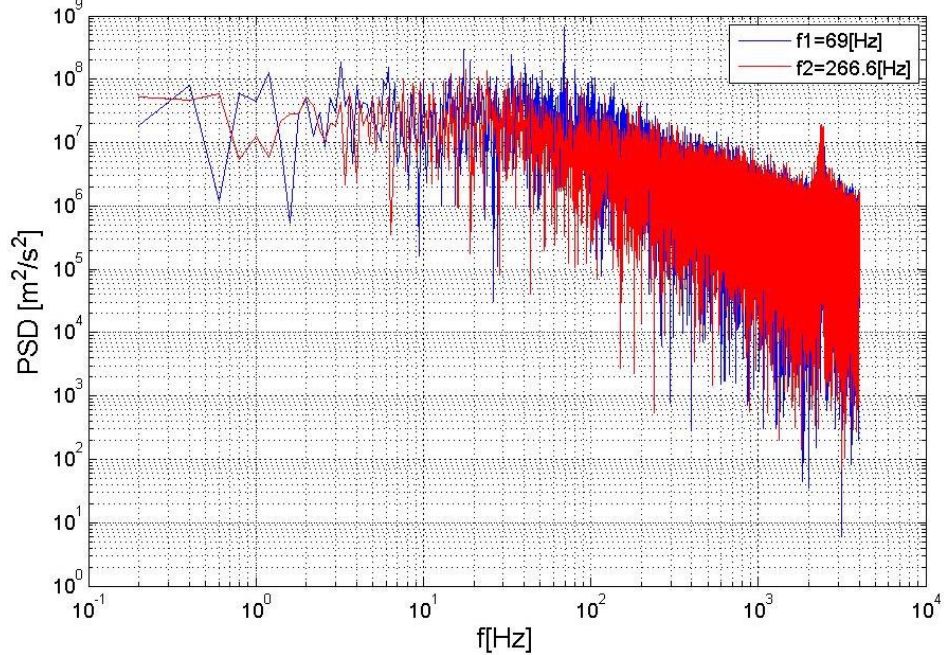
Figure 17. Power spectra at Re = 200,000 and α = 24 ◦